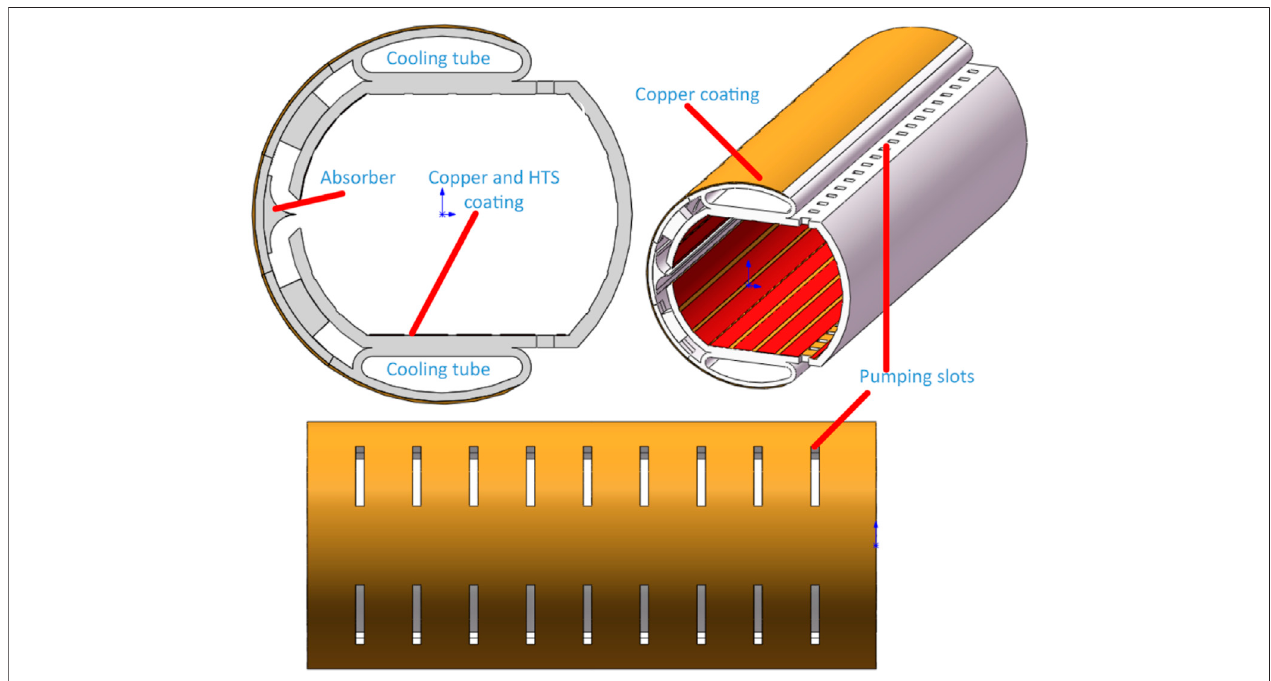
FIGURE 9 | Schematic for the beam screen at